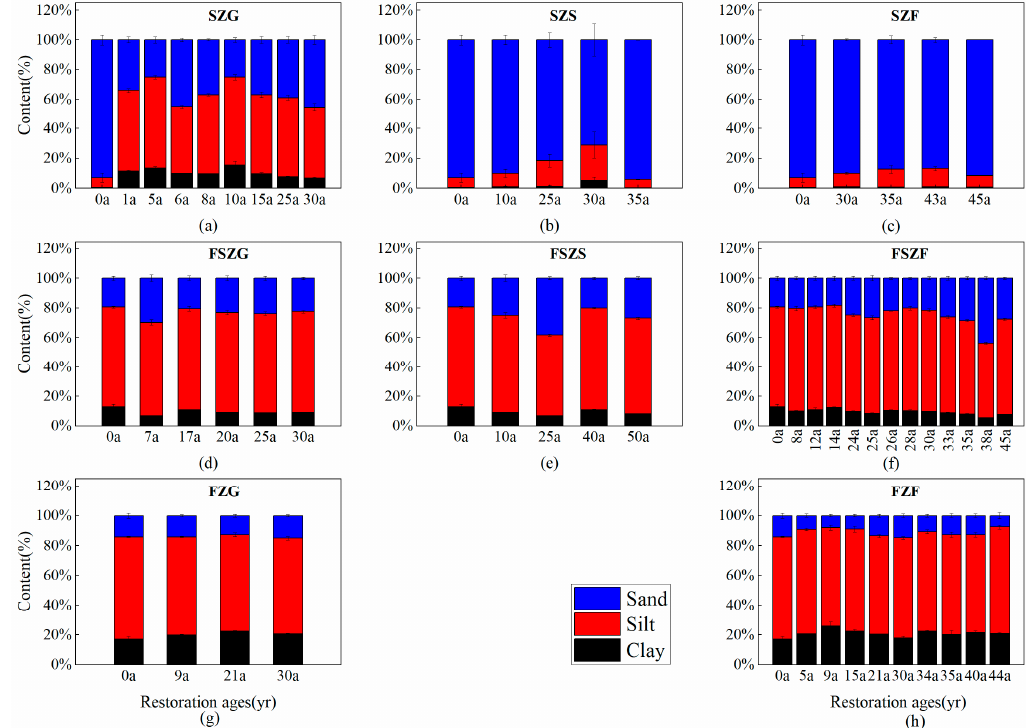
Figure 2. Changes to the PSD of soil in different vegetation zones across the vegetation restoration chronosequence. ( a – c ) show changes to particle size distribution (PSD) of soil with restoration age in the steppe zone grassland (SZG), steppe zone shrubland (SZS), and steppe zone forest (SZF), respectively; ( d – f ) show changes to PSD with restoration age in the forest-steppe zone grassland (FSZG), forest-steppe zone shrubland (FSZS), and forest-steppe zone forest (FSZF), respectively; ( g – h ) show variation in the PSD of grassland (FZG) and forest (FZF) with restoration age in the forest zone, respectively. Note: values are mean ± standard error.